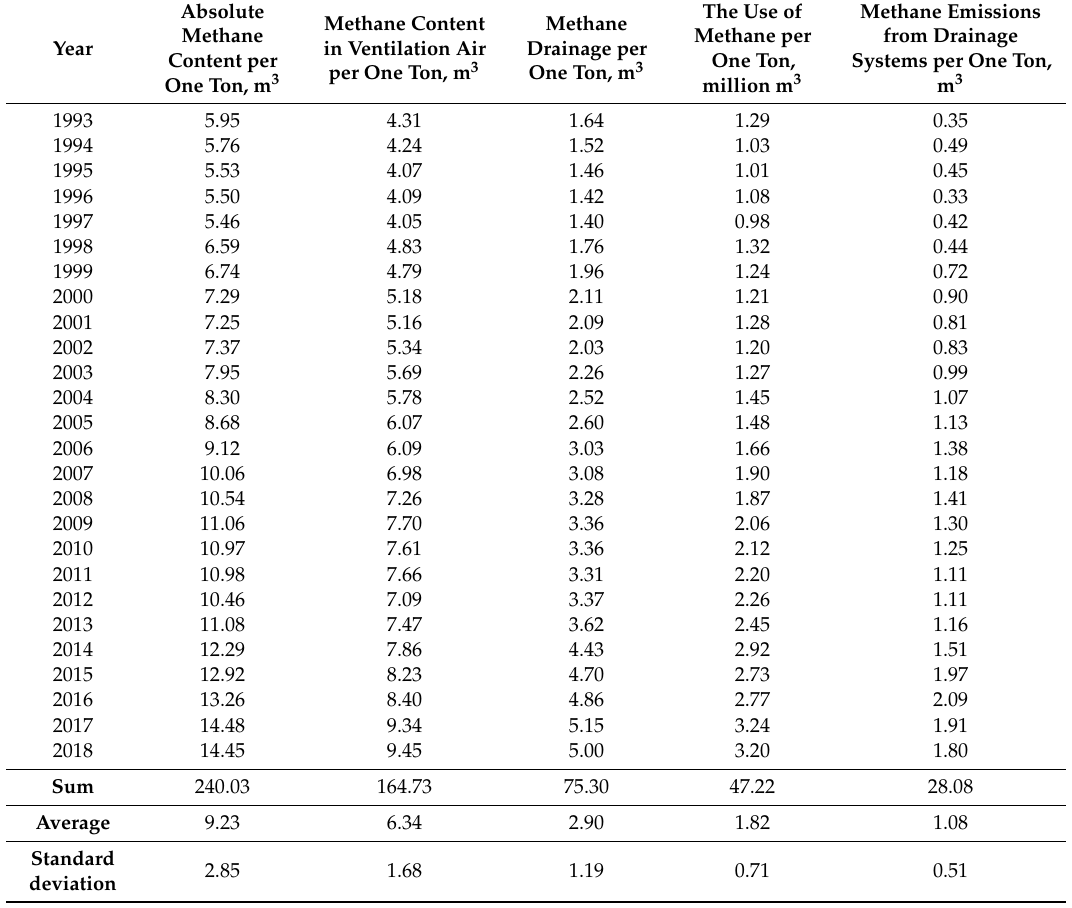
Table 2. Total methane emissions, ventilation methane emissions, amount of methane drainage, use of methane, and methane emissions from drainage systems per one ton of extracted coal.